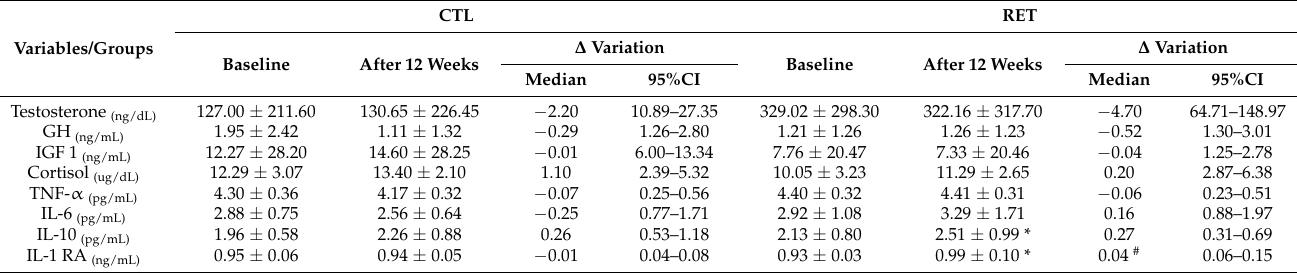
Table 4. Evaluation of biochemical